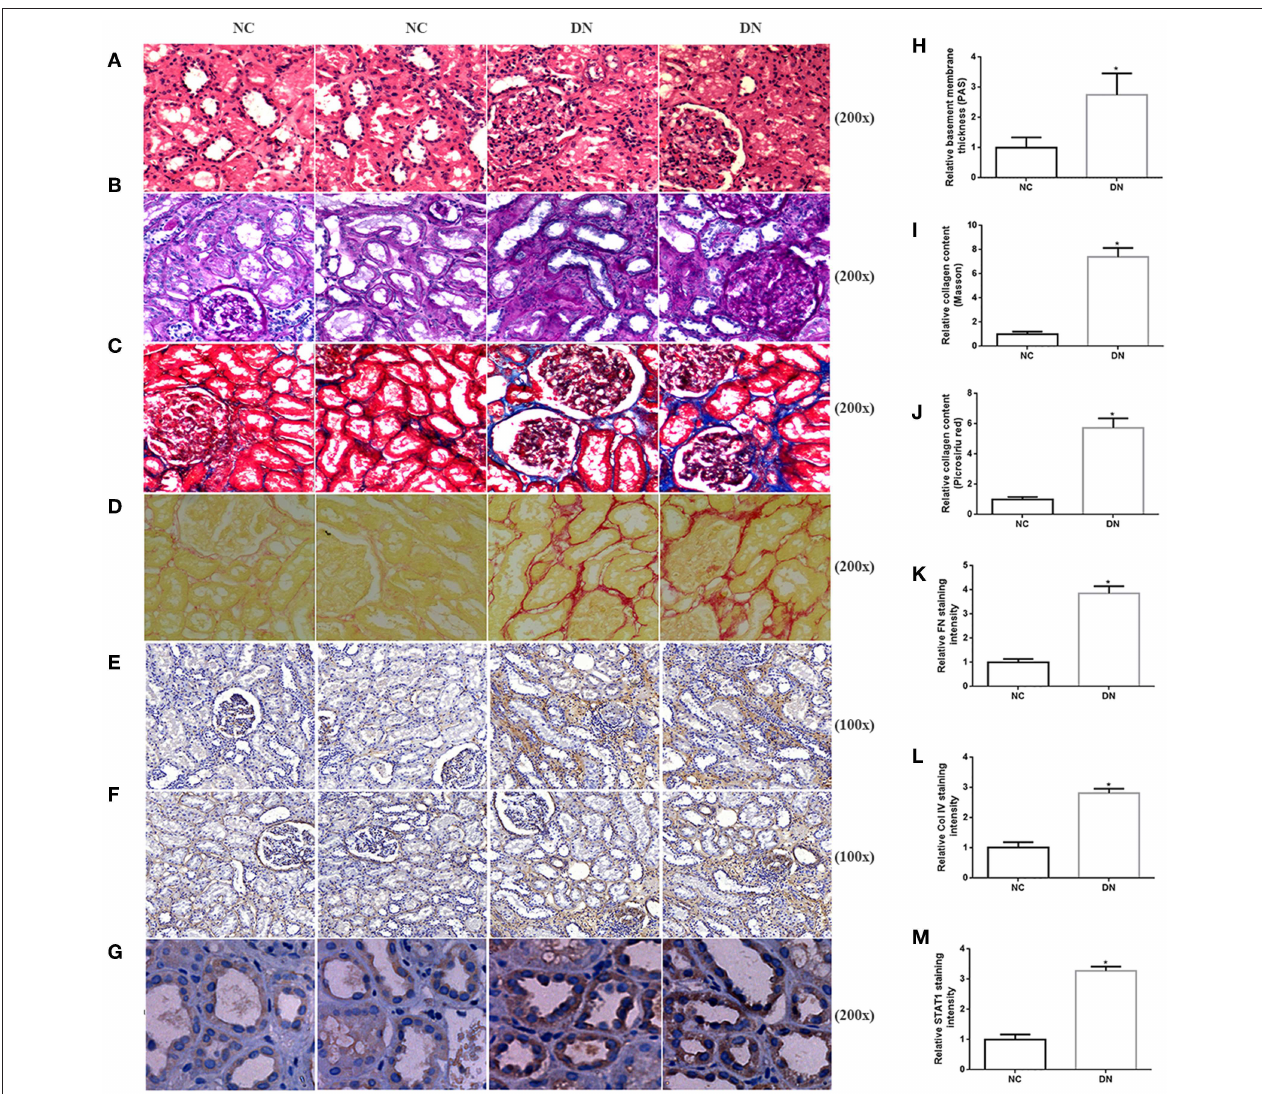
FIGURE 2 | Histopathological examination of non-diabetic adjacent normal kidney tissues (NC) and renal biopsy sections from DN patients. Representative images of (A) HE staining, (B) PAS staining, (C) Picrosirius red staining, and (D) Masson’s trichrome staining for assessing TIF. Immunohistochemistry staining of (E) FN, (F) Col IV, and (G) STAT1 in human kidney sections. Original magnification, 100–200x. Quantitative analysis of (H) PAS staining, (I) Picrosirius red staining, (J) Masson’s trichrome staining, (K) relative FN staining intensity, (L) relative Col IV staining intensity, and (M) relative STAT1 staining intensity. All data are expressed as means ± SEM, n = 10 (* P < 0.05 vs.